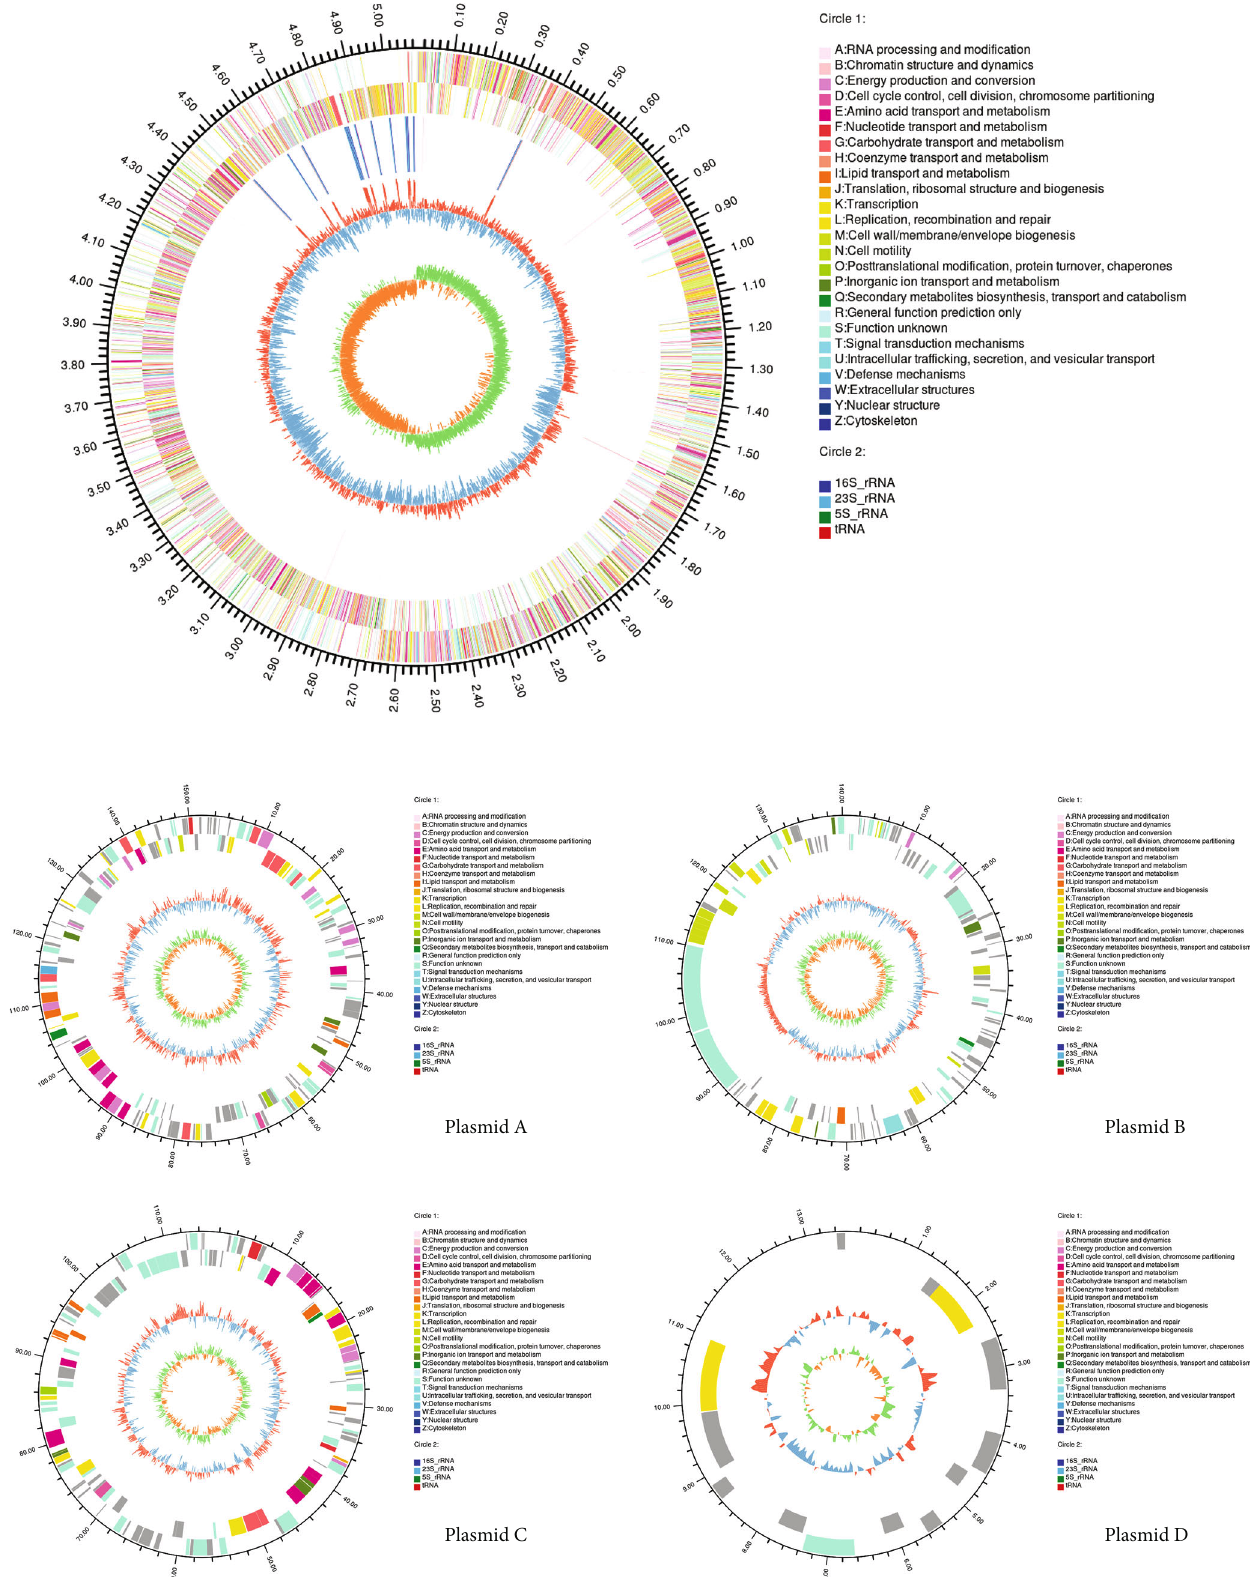
Figure 6: Circos evaluation of Bacillus megaterium